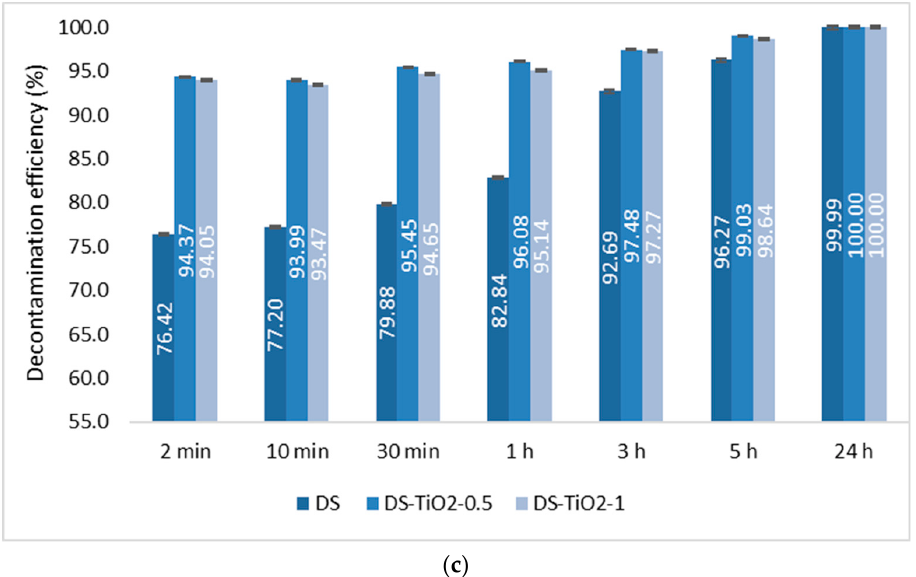
Figure 9. Decontamination degrees (%) of sulfur mustard (HD) obtained for decontamination formulations containing: ( a ) ZnO, ( b ) TiO 2 , and ( c ) zeolite (detailed statistical data presented in Tables S9 and S10—Supplementary Material File).